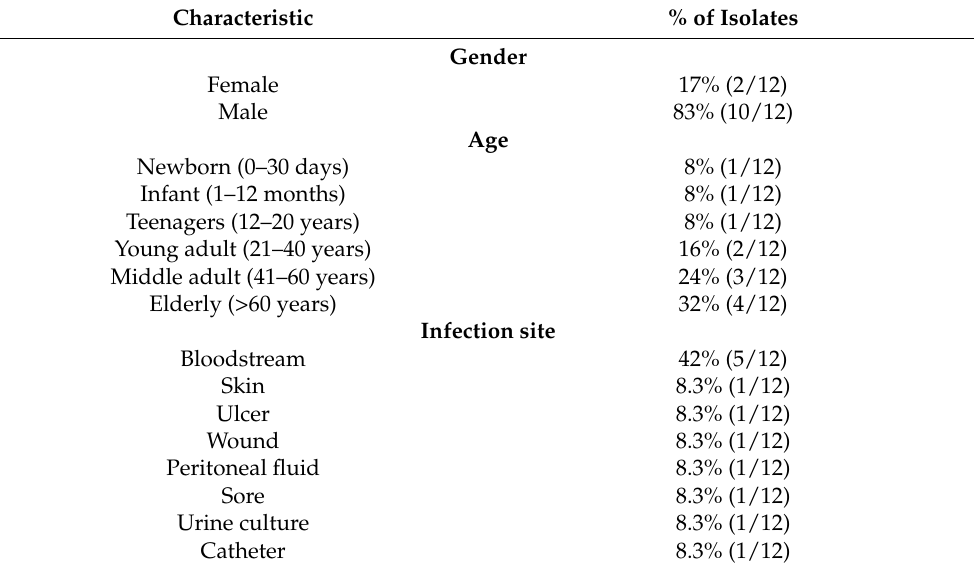
Table 3. Demographic characteristics corresponding to the E. cloacae complex isolates carrying the bla KPC